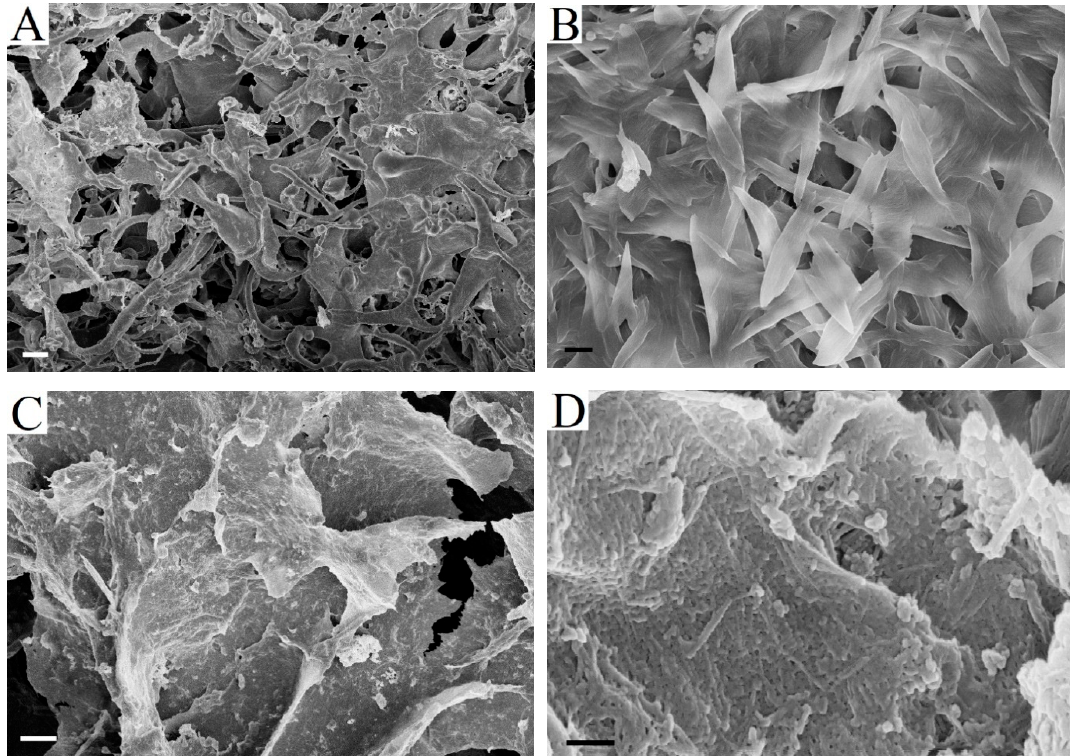
Figure 9. Images of cellulose residue fractions after enzymatic hydrolysis of BHP over 72 h: ( A and B ) the top fraction of cellulose residue in different magnification; ( C and D ) the bottom fraction of cellulose residue in different magnification. Bars: A—10 μ m; B—1 μ m; C—10 μ m; and, D—200 nm.